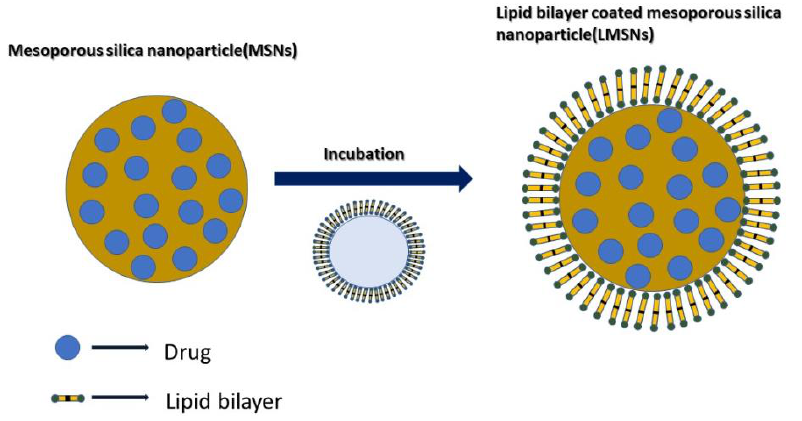
Figure 4. Figure showing the mechanism of lipid coating in the Mesoporous Silica Nanoparticles.